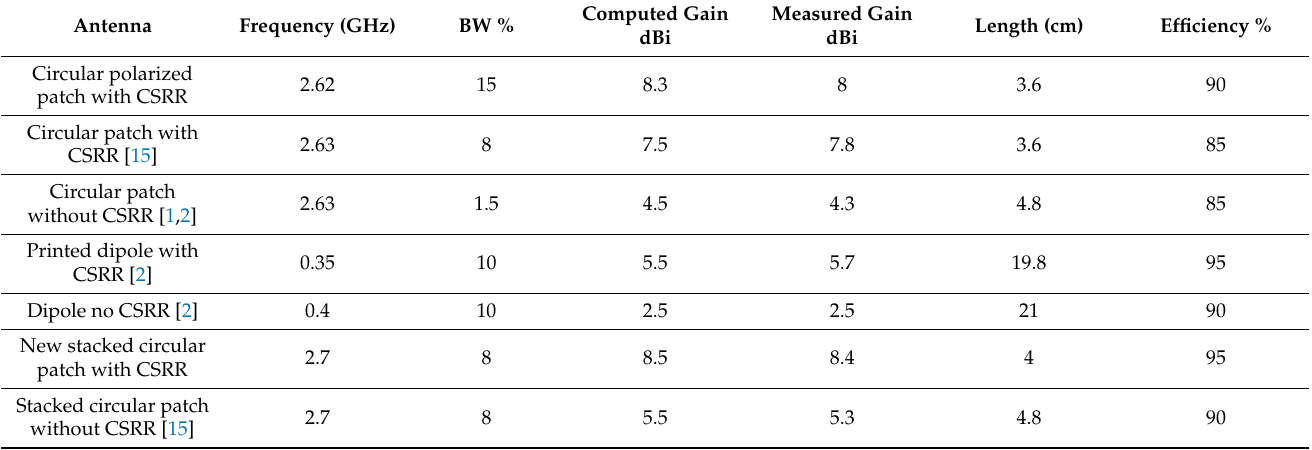
Table 10. Electrical performance of antennas without and with